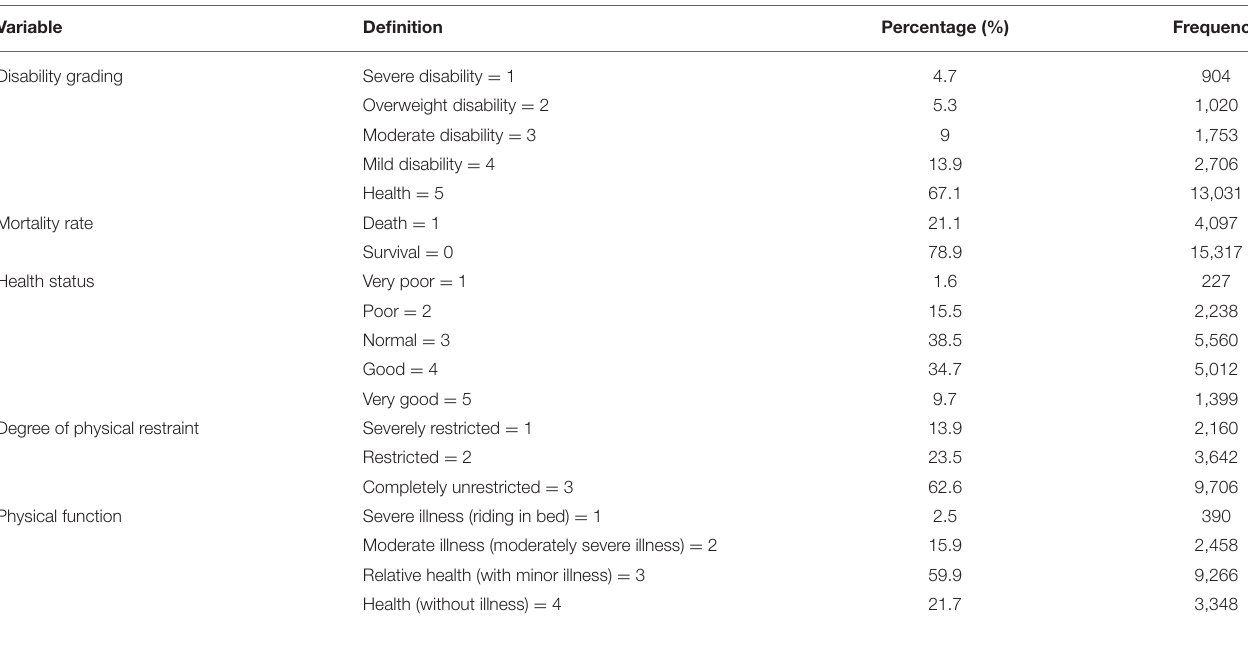
TABLE 1 | Descriptive statistics of core